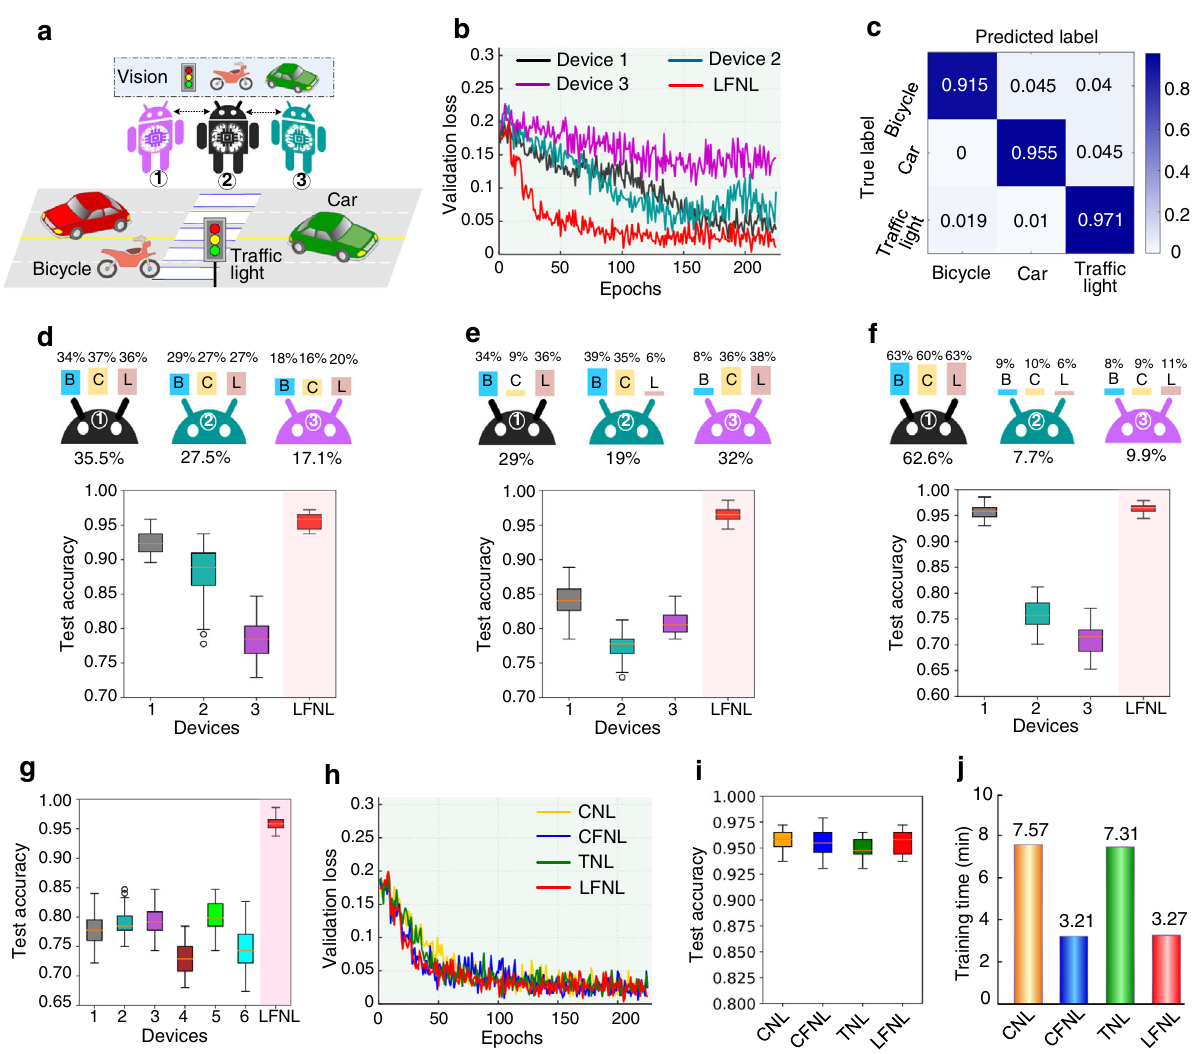
Fig. 3 | LFNL for visualrecognitionona road. a An exampleof visual recognition (image classi fi cation) on a road, including bicycle, car, and traf fi c light image classes. b Validation loss curves for three locally training devices and LFNL. c Confusion matrix for the test set in LFNL after training. d – f Box plots show test accuracy performed for three locally training devices and LFNL with uneven